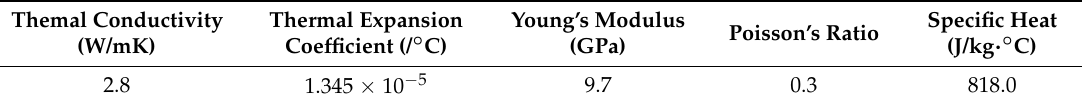
Table 5. Material properties for model